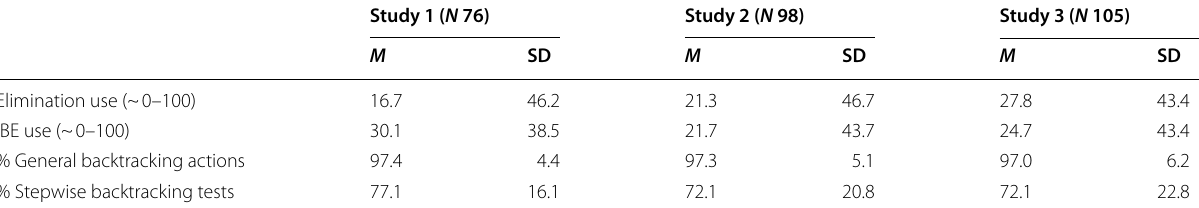
Means were averaged across the 10–18 experimental problems each participant completed and then across participants